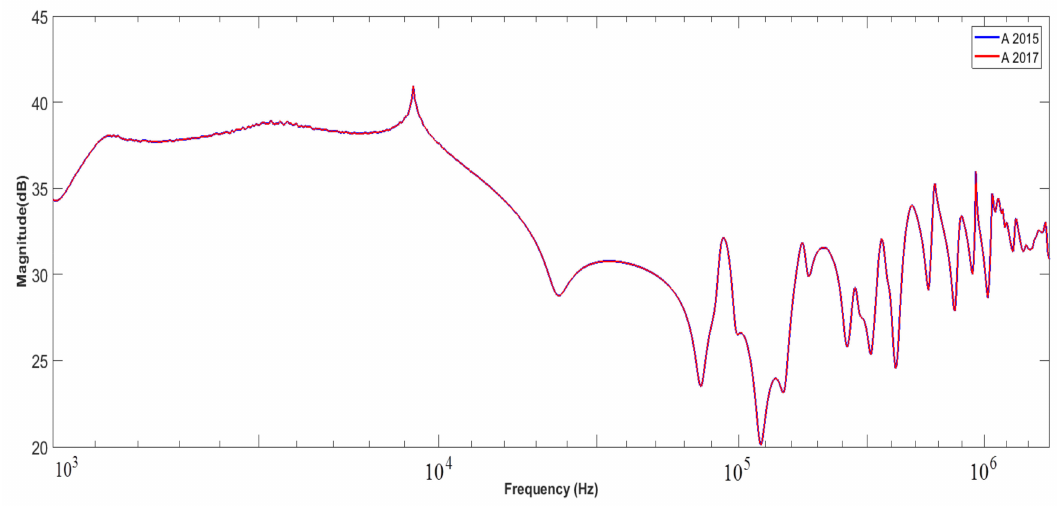
Figure 7. Frequency response based on a fingerprint comparison.